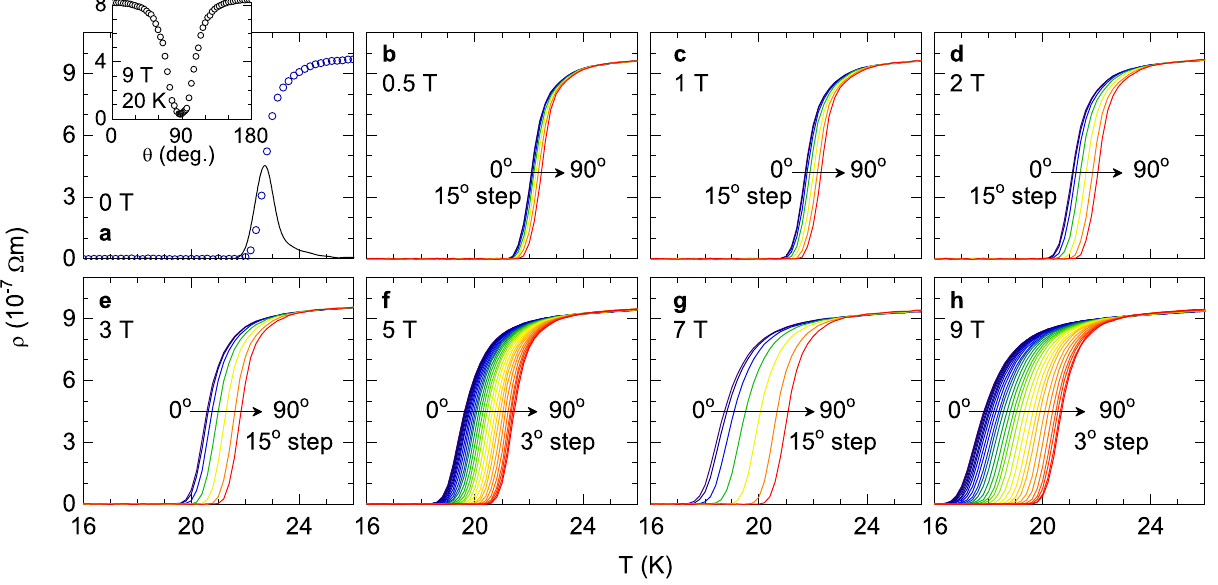
Figure 1. Temperature dependence of the in-plane resistivity around T c in the presence of magnetic fields with different amplitudes (from 0 to 9 T, a to h ), and different orientations with respect to the crystal c axis. T c = 22.7 K was determined as the temperature at which ( d ρ/ dT ) H = 0 is maximum (solid line in a ). Inset in ( a ): ρ(θ) measurement performed before the measurements in ( a – h ) to determine the precise θ = 90 ◦